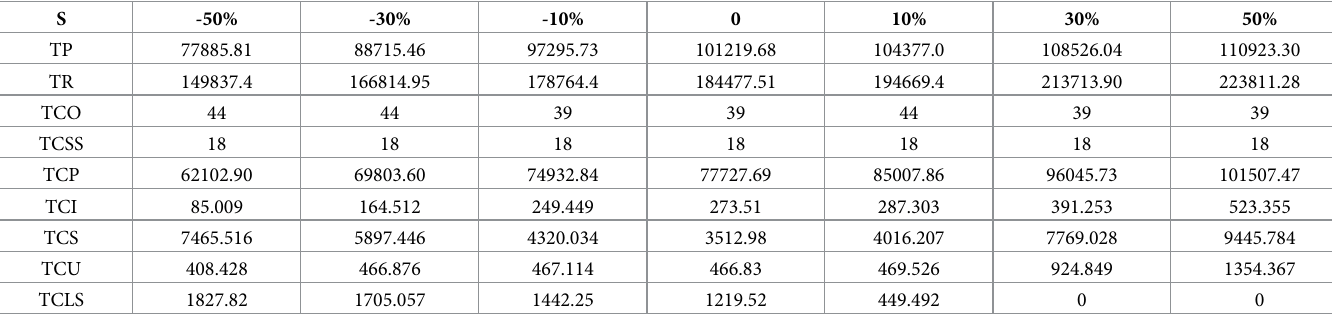
Table 7. The costs and sales profits obtained by the changes in the total shelf space